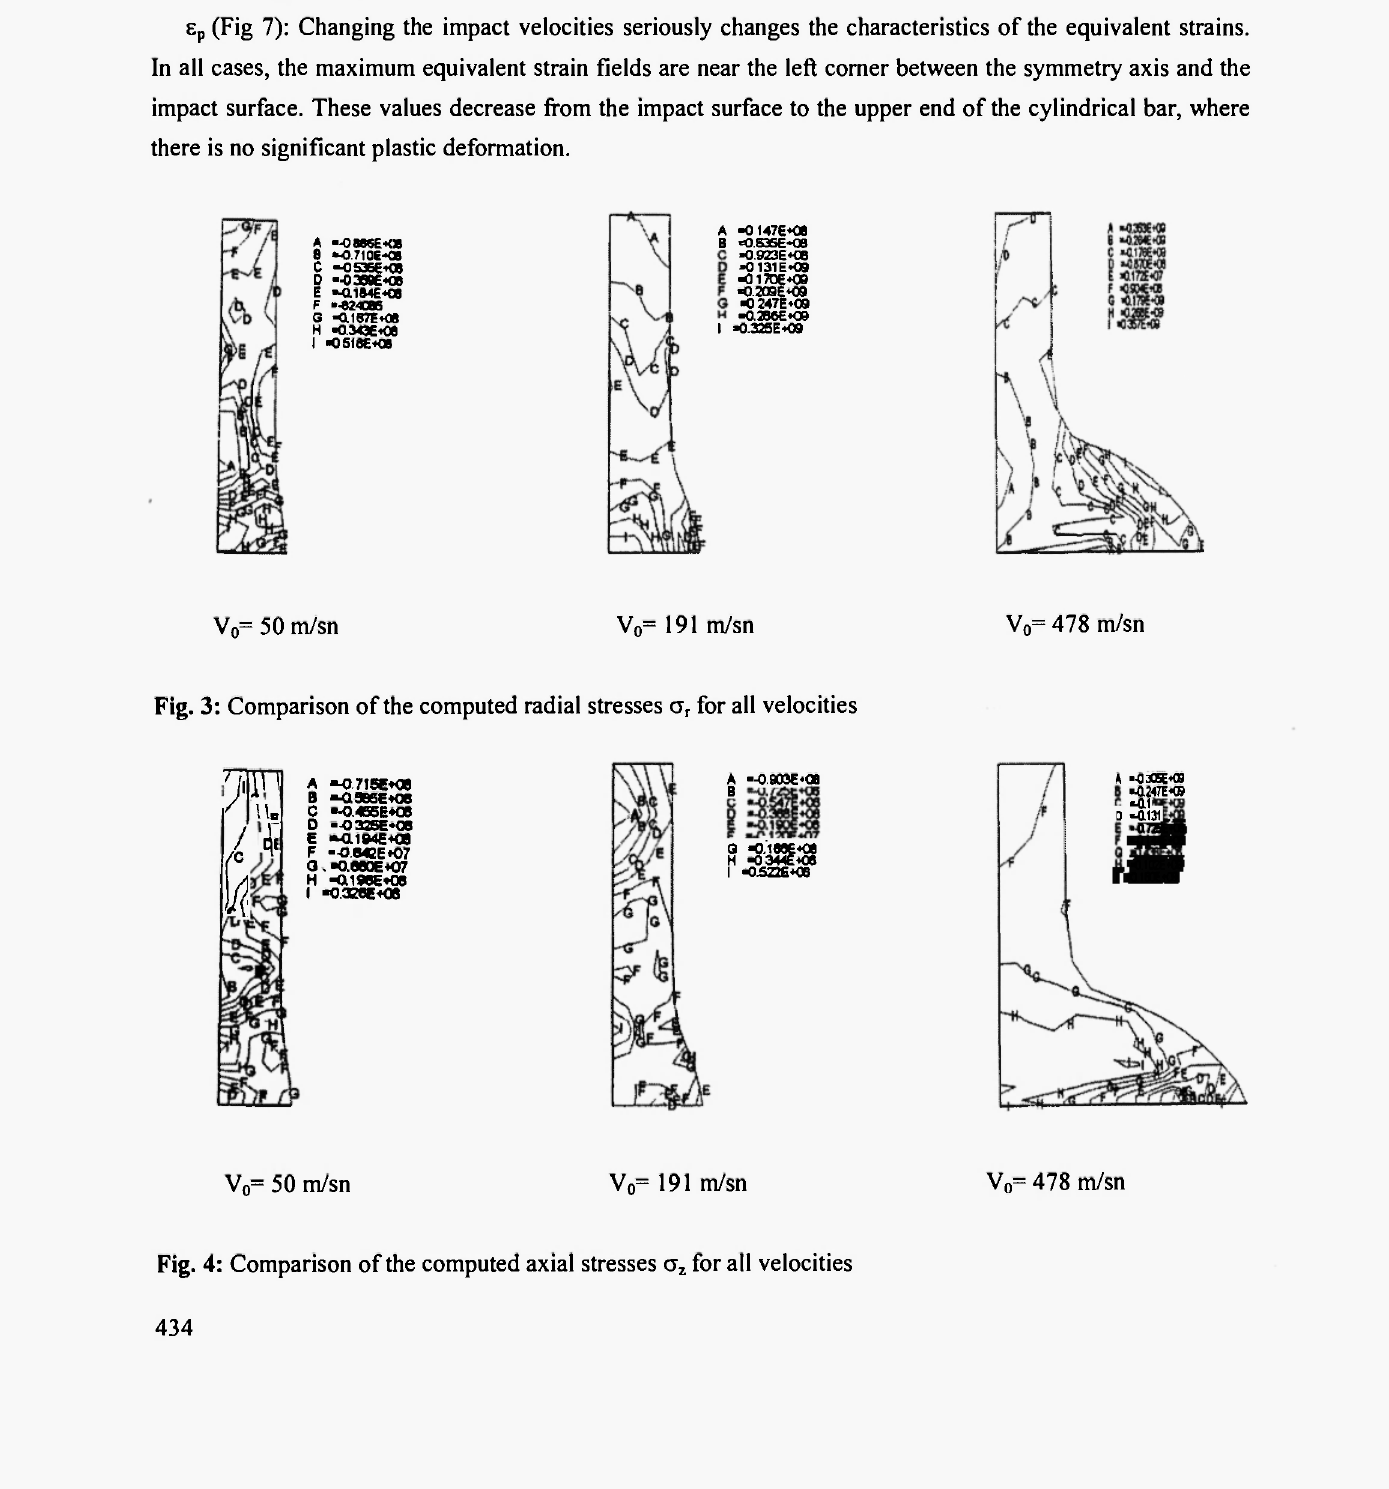
Fig. 4: Comparison of the computed axial stresses σ ζ for all